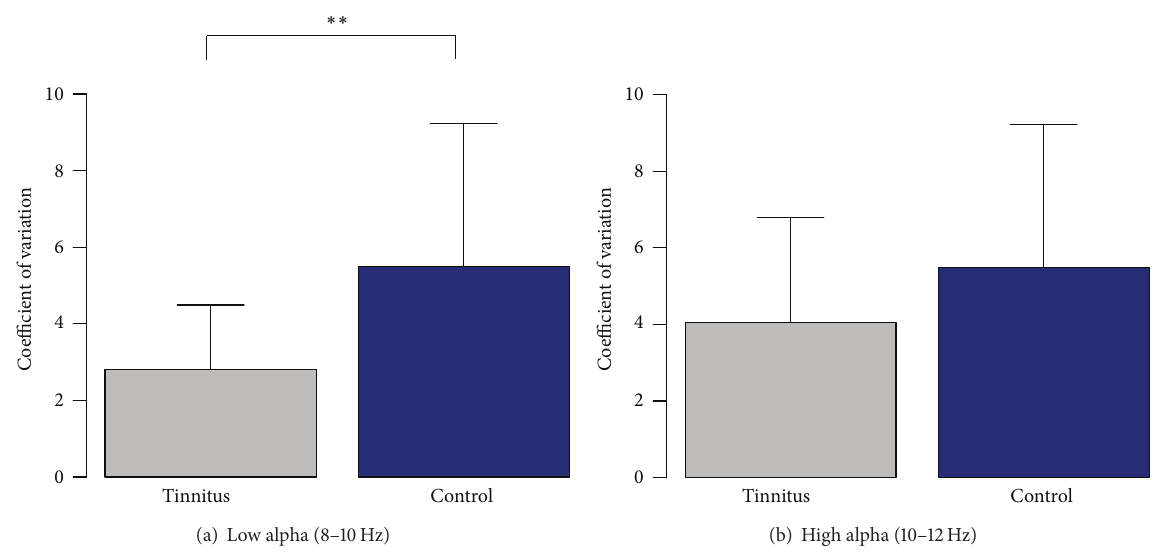
Figure 4: Alpha variability group comparison. The bar plots demonstrate the group difference for the variability of the temporal alpha power. Coefficients of variation are shown for both groups, for the lower and upper alpha band separately. Group differences are only significant for the lower alpha band from 8 to 10Hz with 𝑃 = 0.004 .